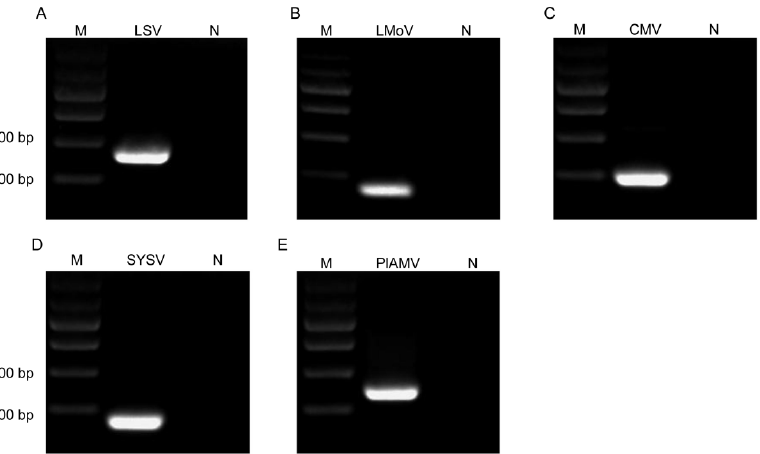
Figure 3. Determination of specificity of five primer pairs by uniplex RT-PCR to detect LSV ( A ), LMoV ( B ), CMV ( C ), SYSV ( D ), and PlAMV ( E ). Lane M, 100 bp plus DNA ladde.